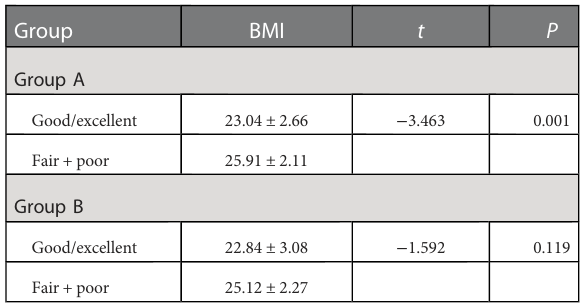
TABLE 5 Comparison of BMI in subgroups with different functional